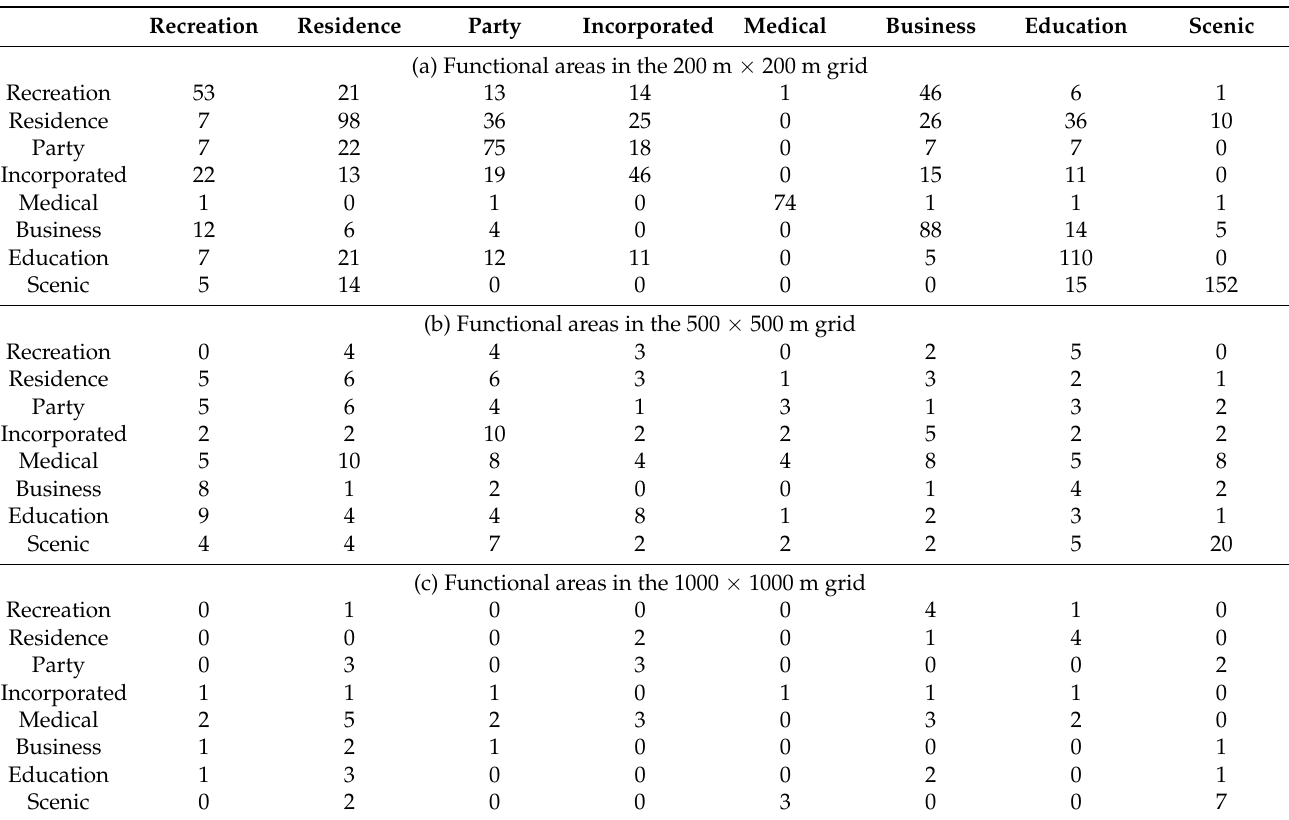
Table 2. Mixed-functional areas in the Xicheng District,